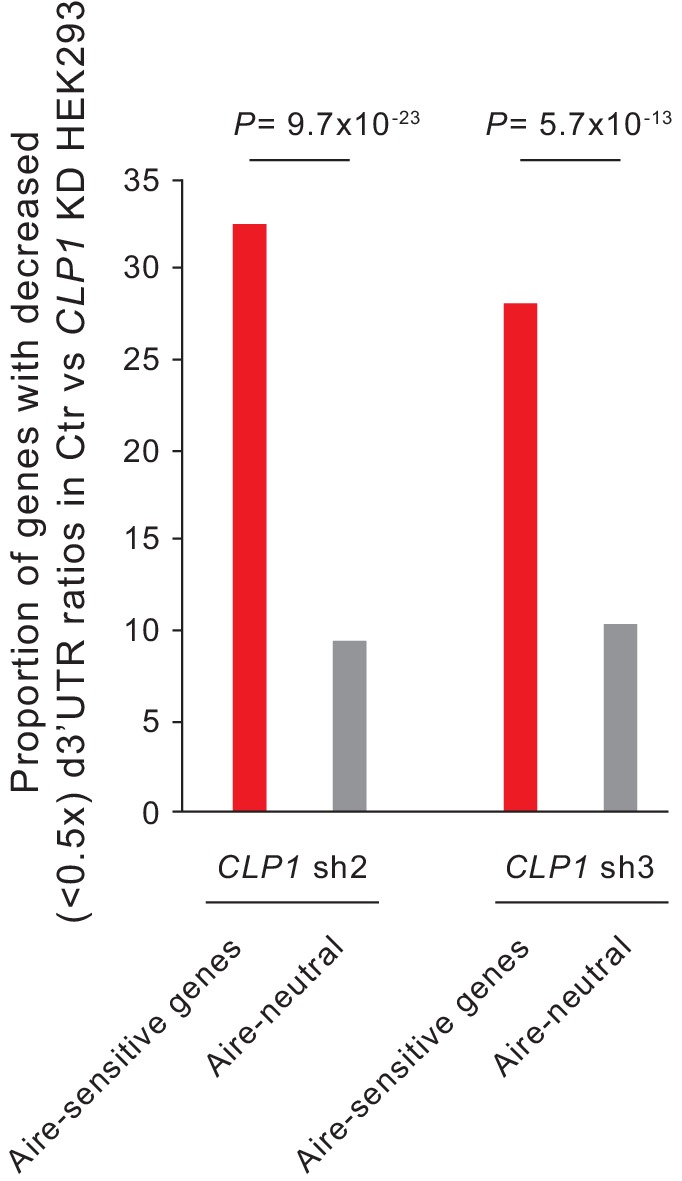
Proportion of genes subject to CLP1-mediated 3’UTR shortening in Aire-sensitive and neutral genes in HEK293 cells.Genes with decreased (<0.5 x) d3’UTR ratios in Ctr versus CLP1 sh2 or sh3 knockdown HEK293 cells are compared to the number of genes for which the level of 3'UTR length variation can be measured. Statistical significance was assessed by a Chi-squared test.